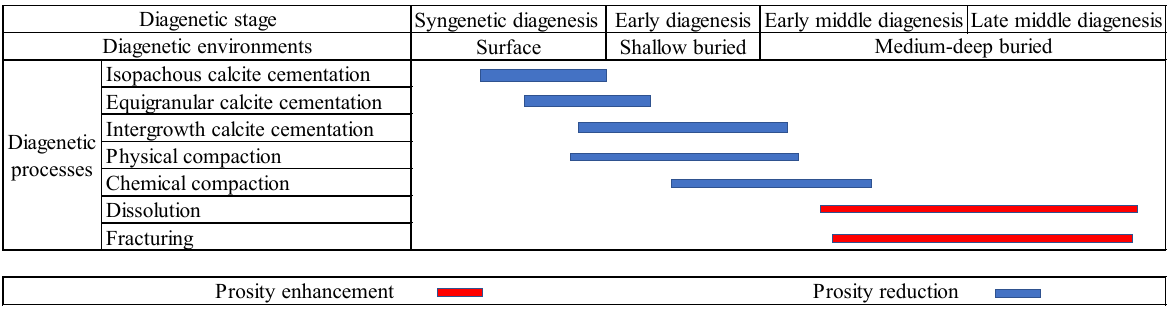
Figure 9. Paragenetic sequence of diagenetic processes in the Callovian-Oxfordian stage in the studied area. Effects of diagenetic processes on porosity are shown as blue (for porosity reducing), red (porosity enhancing reducing).